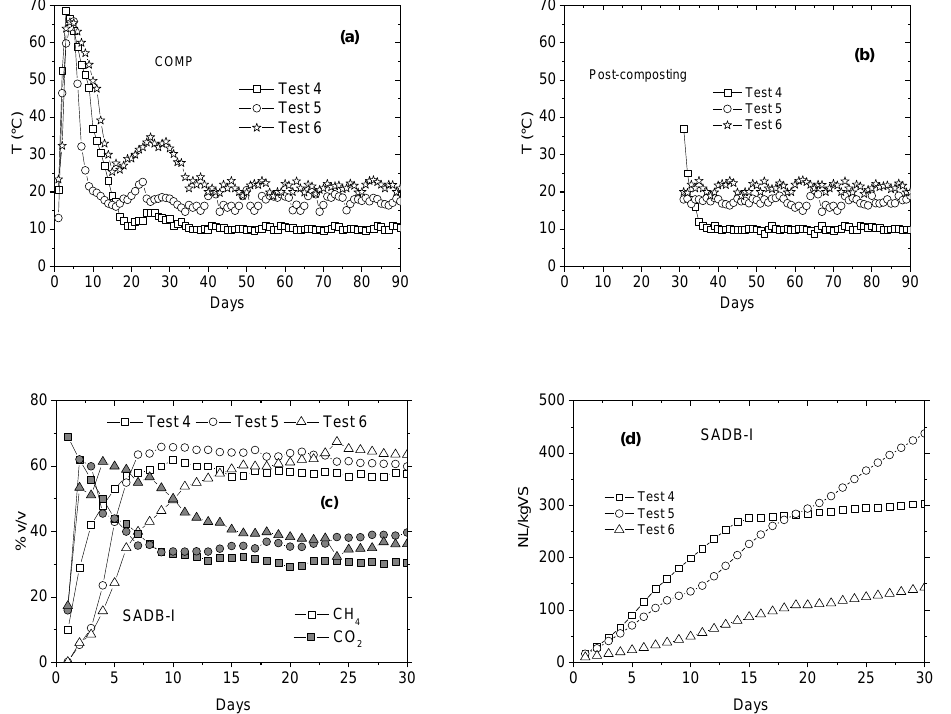
Figure 4. Temperatures during composting of the OFMSW ( a ) and of post-composting of the digestate ( b ), biogas composition ( c ) and the cumulative production vs. days for the runs with SADB-I (with inoculum) ( d ).